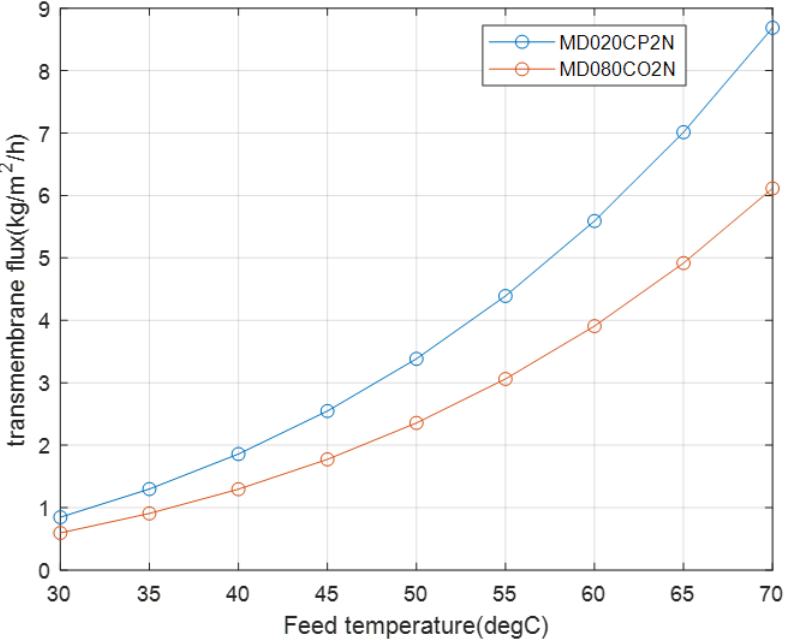
Figure 7. Transmembrane fluxes of MD020CP2N and MD080CO2N modules with different membrane thickness (0.05 and 0.65 mm) and the same number of fibers (40).